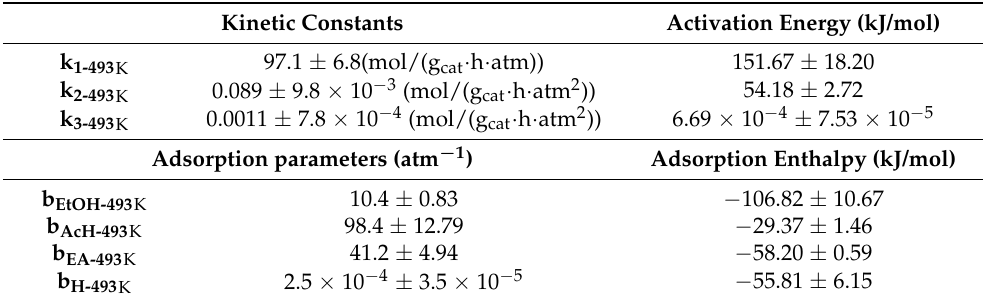
Table 1. Optimized kinetic parameters obtained for a commercial copper-copper chromite catalyst, from [28], reported with the permission of